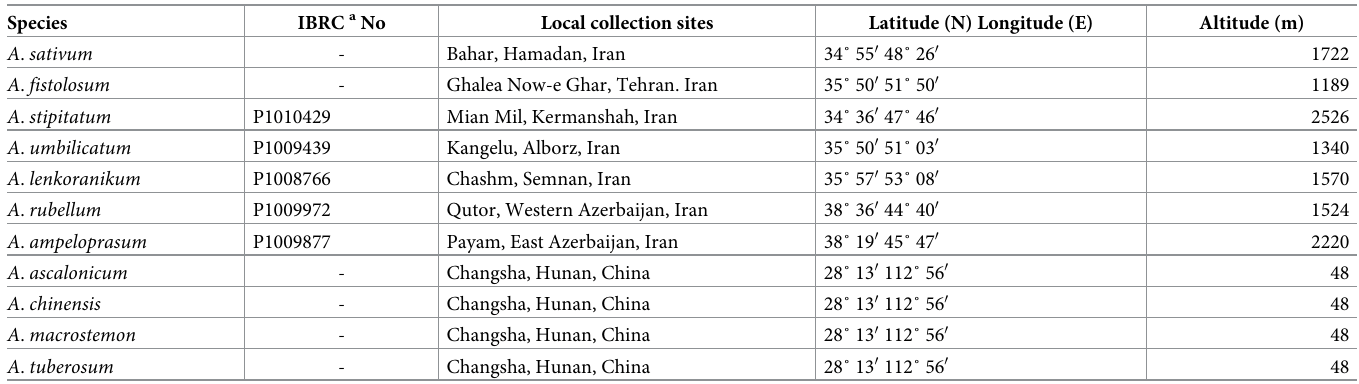
Table 5. Local information of studied Allium